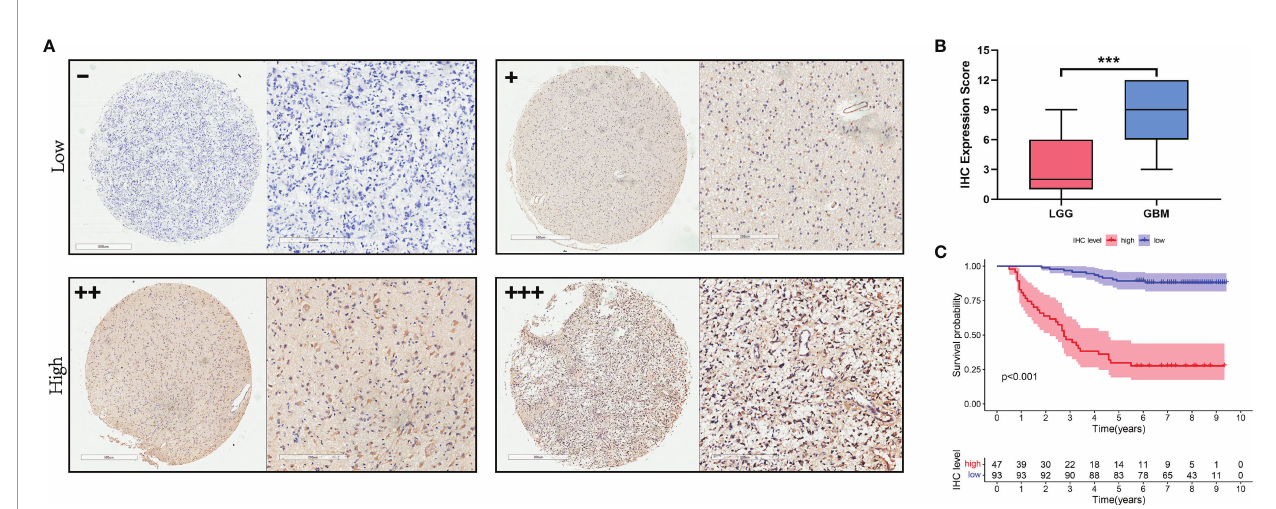
FIGURE 5 | The expression of NCAPG in glioma TMA. (A) The expression and distribution of NCAPG in representative tissue specimens. (B) The relationship between NCAPG expression and glioma grade in the tissue microarrays (TMA). (C) Survival curve and NCAPG expression in glioma TMA. (-: Negative for a score of 0, +: Weak for a score of 1-4, ++: Moderate for a score of 5-8, +++: Positive for a score of 9-12, ***P <